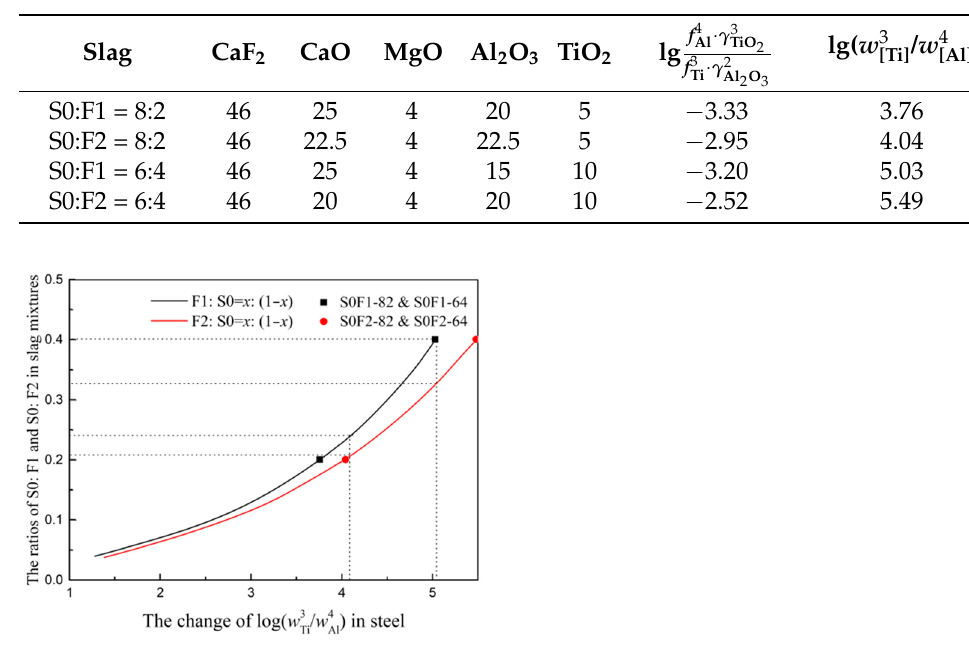
Table 6. The relationship between lg ( w 3